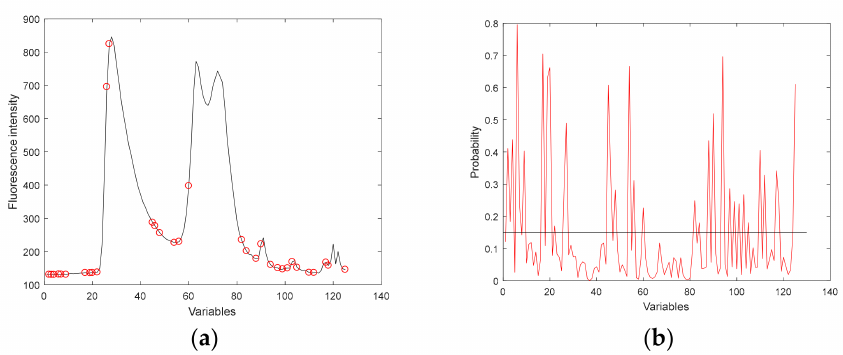
Figure 10. The extraction process of RF: ( a ) distribution of effective variables; ( b ) the probability distribution of